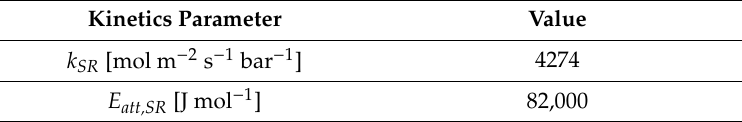
Table 1. Reference kinetics coe ffi cients [52].